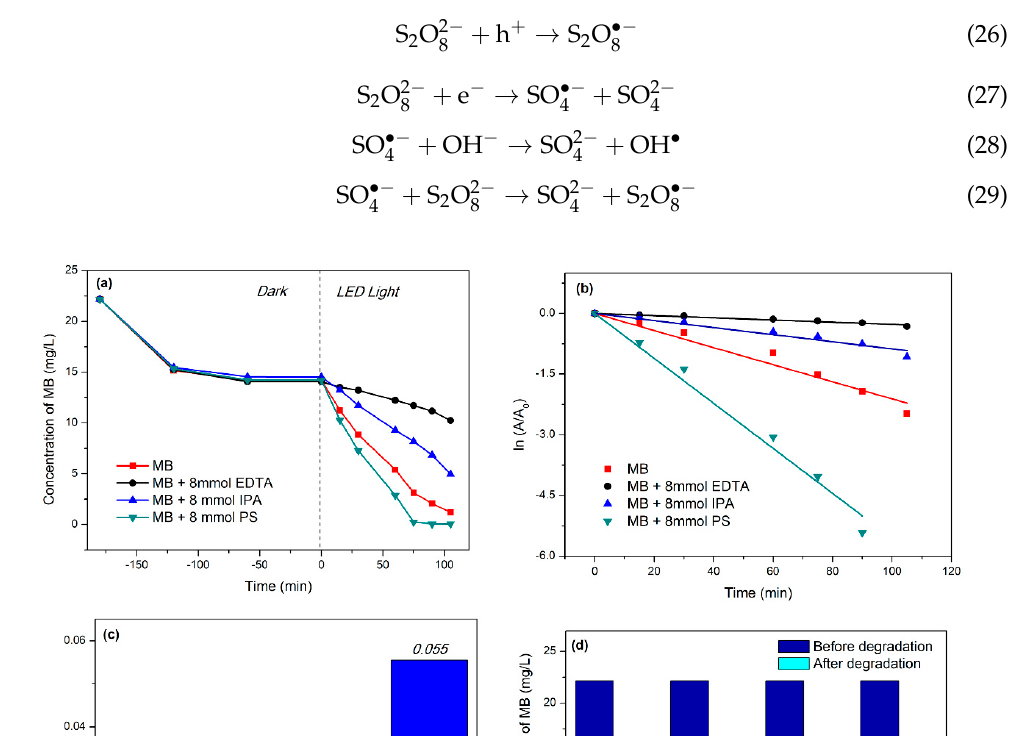
after the degradation process.